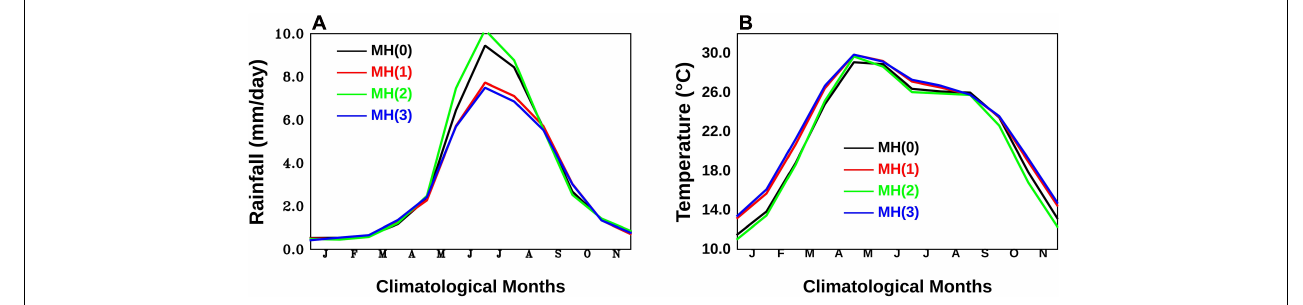
FIGURE 9 | Comparison between the area-averaged seasonal cycle of Mid-Holocene (MH) simulations, (A) is for the simulated rainfall, and (B) is for the simulated surface temperature over the Indian land region. Here, MH(0) is MH Control simulations; MH(1) is MH simulation with HS orbital values; MH(2) is MH simulation with